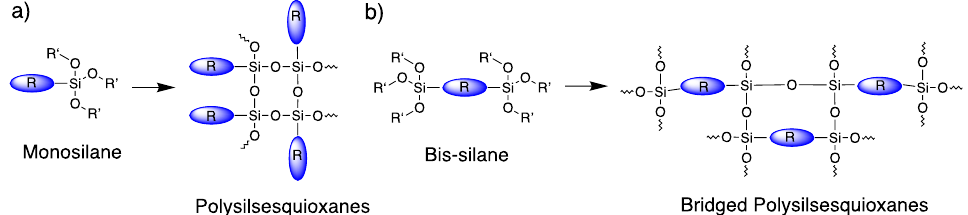
Figure 2. Polysilsesquioxanes obtained from ( a ) organoalkoxy monosilane and ( b ) organoalkoxy bis-silane. (R)—organic functionality; R’—an alkyl or aryl group.